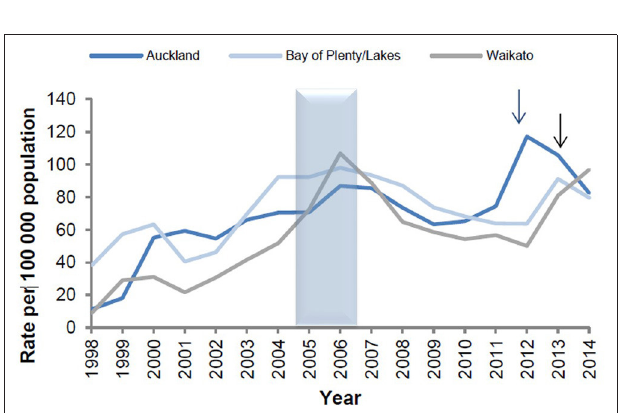
FIGURE 2 | Reported gonorrhea rates in New Zealand 1998–2014, selected sentinel regions (26). Arrows denote shifts from culture testing to NAAT